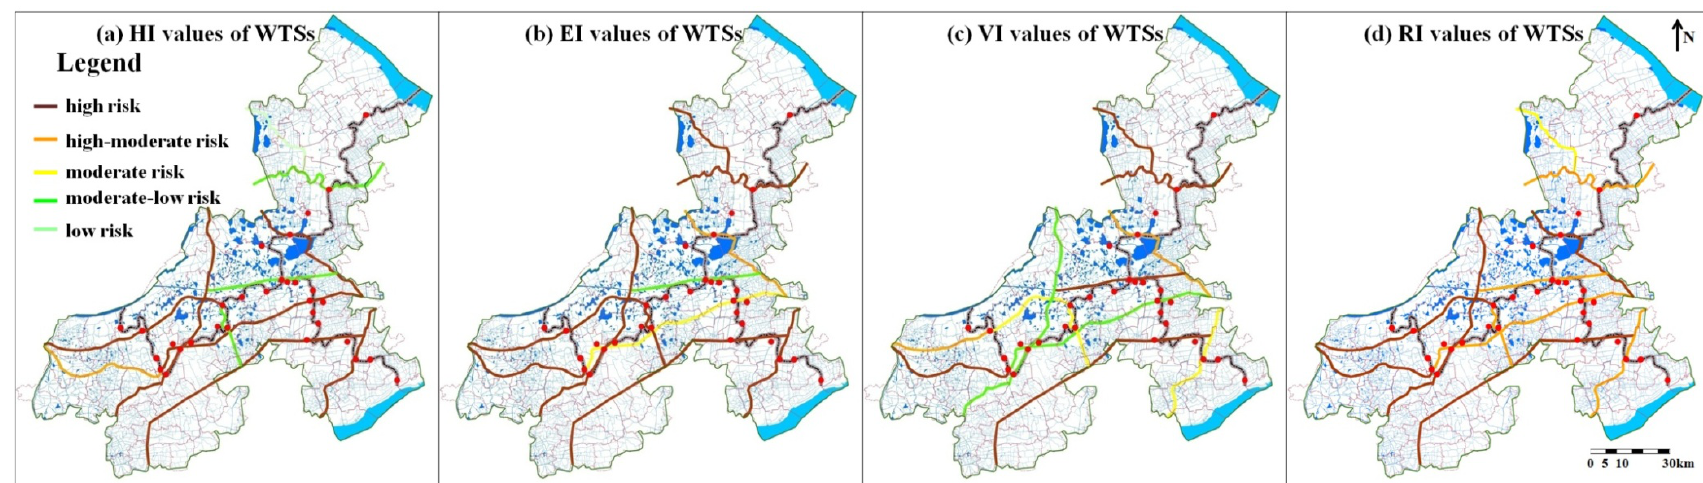
Figure 8. Spatial distribution of HI, EI, VI and RI values of the NPSs.